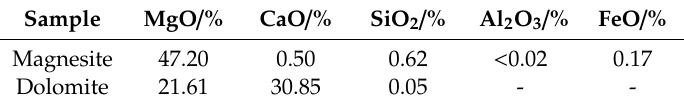
Figure 1. X-ray di ff raction pattern of magnesite ( a ) and dolomite ( b ). Figure 1. X-ray diffraction pattern of magnesite ( a ) and dolomite ( b ). Table 1. Chemical composition of magnesite and Table 1. Chemical composition of magnesite and dolomite.